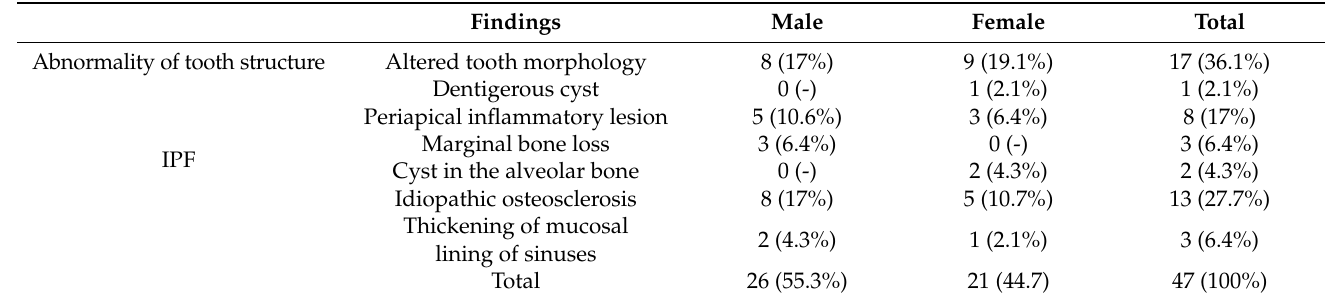
Table 2. Incidental pathologic findings and abnormality of structure in males and females. Findings